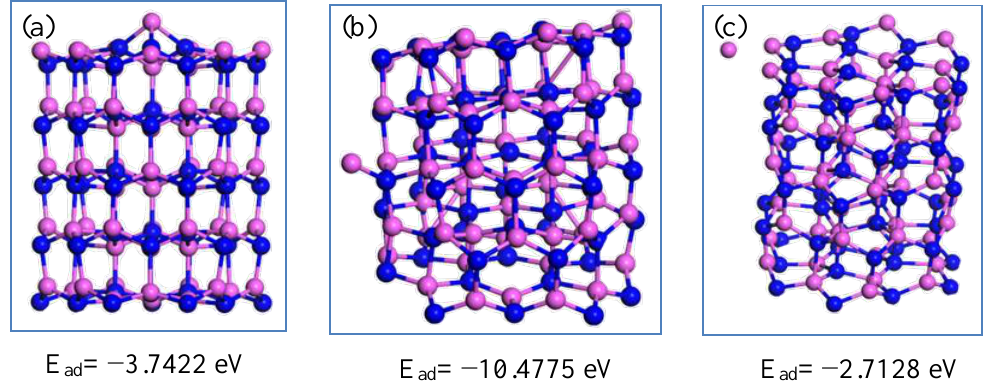
Figure 4. The chemisorption of Al at different sites of the Al 60 N 60 cluster. The Al and N atoms are shown in pink and blue. The Al atom is located at the top, side and edge position of the Al 60 N 60 cluster shown in a , b and c , respectively.